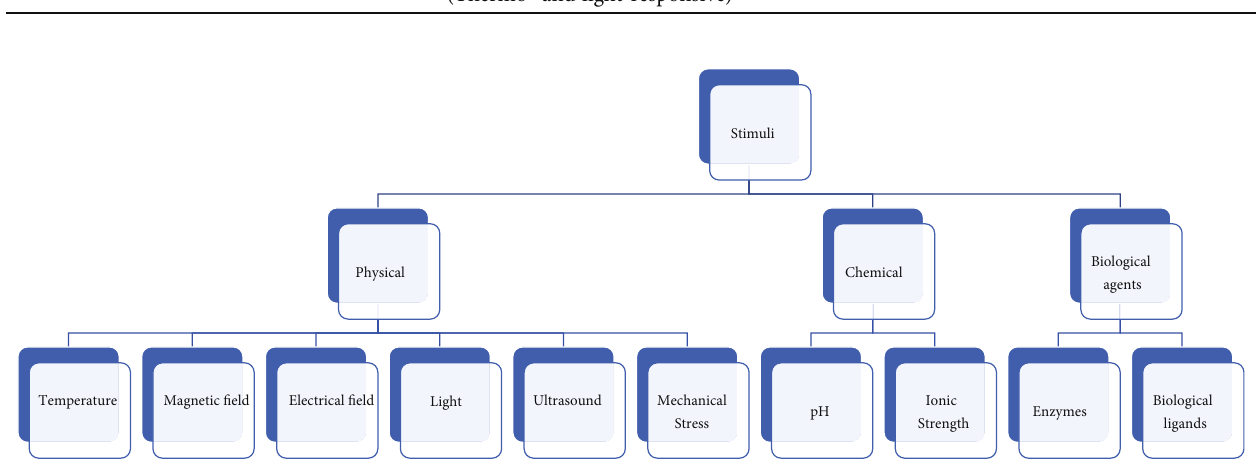
Figure 5: Triggers used in stimuli-responsive fi